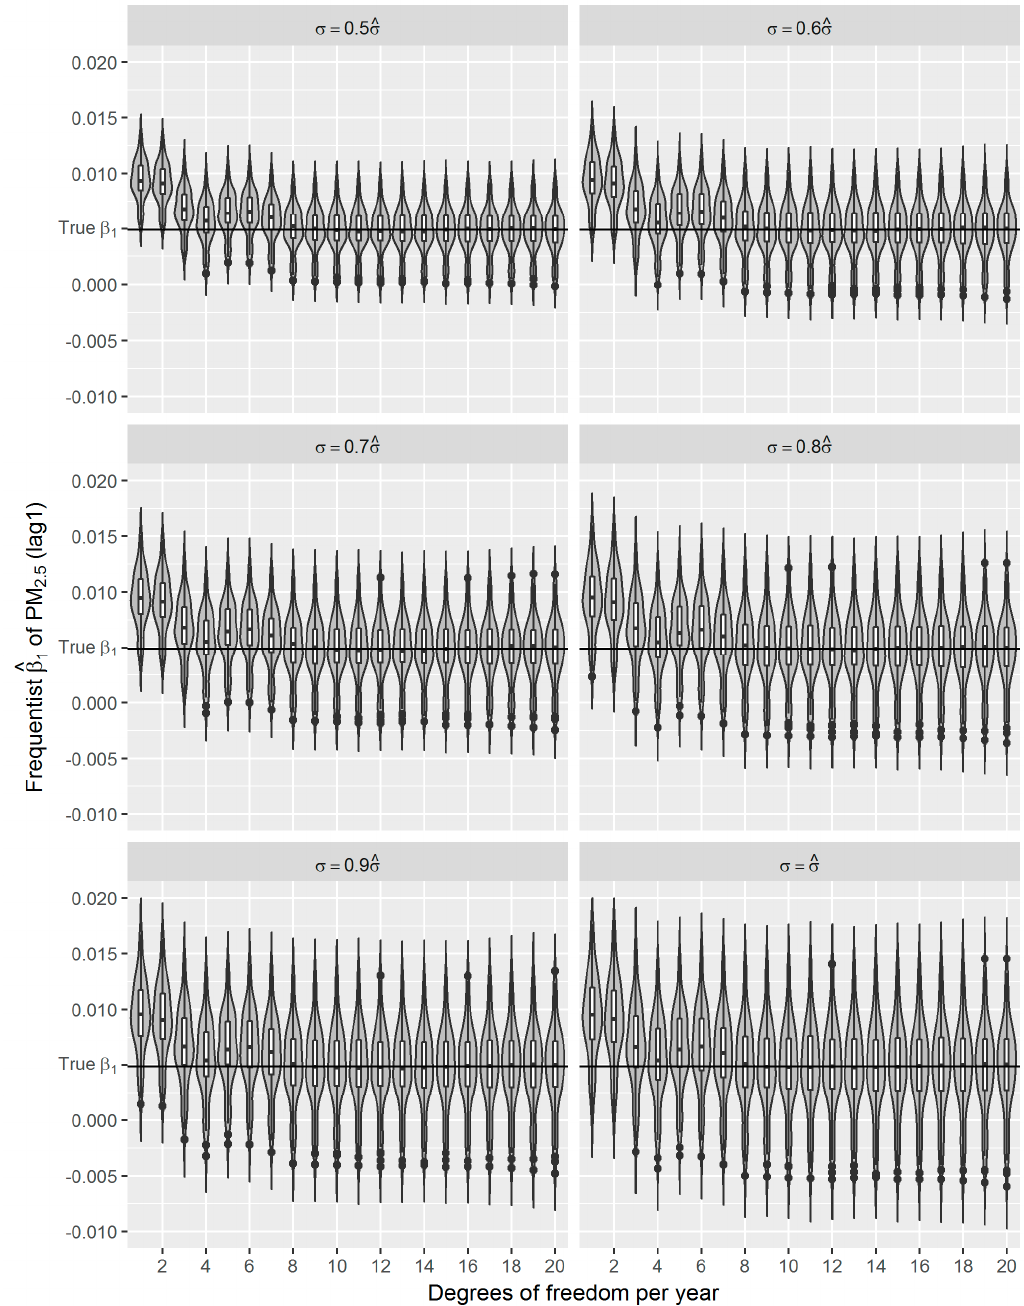
Figure 5. Distributions of frequentist (cid:98) β 1 s for simulated data with different random noises ( σ = 0.5 − 1.0 (cid:98) σ ) and degrees of freedom (1–20 per year) for S ( t ); the true β 1 = 0.0049. In general, although the variance of 𝛽(cid:4632) (cid:2869) s tends to increase as the df for S ( t ) is increased, the